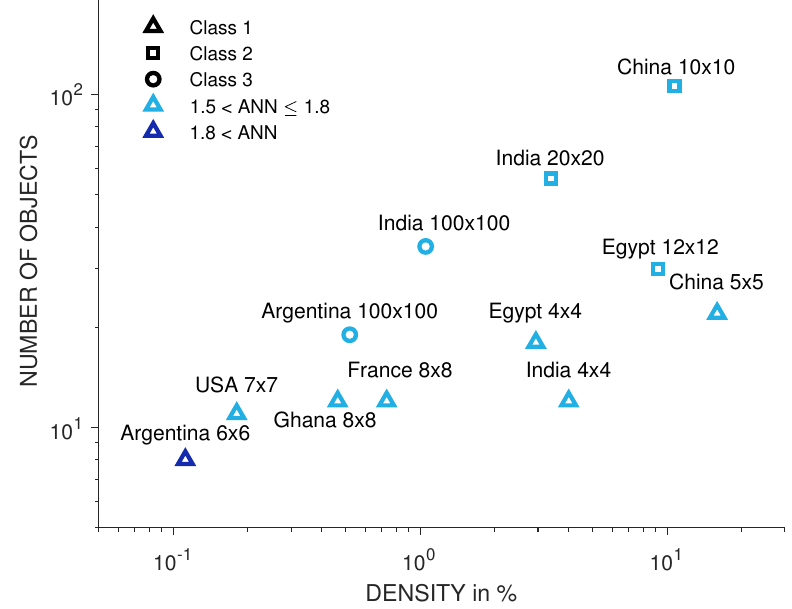
Figure 10. The marker represent the parameters of the chosen sample squares. The numbers following the data set’s name indicate the edge length of the sample